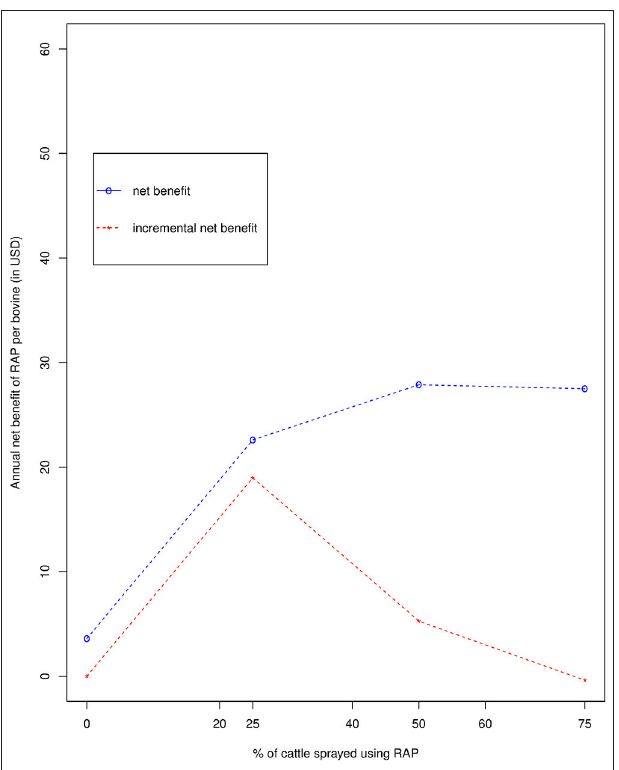
FIGURE 1 | Average and incremental net benefits for each treatment regime.